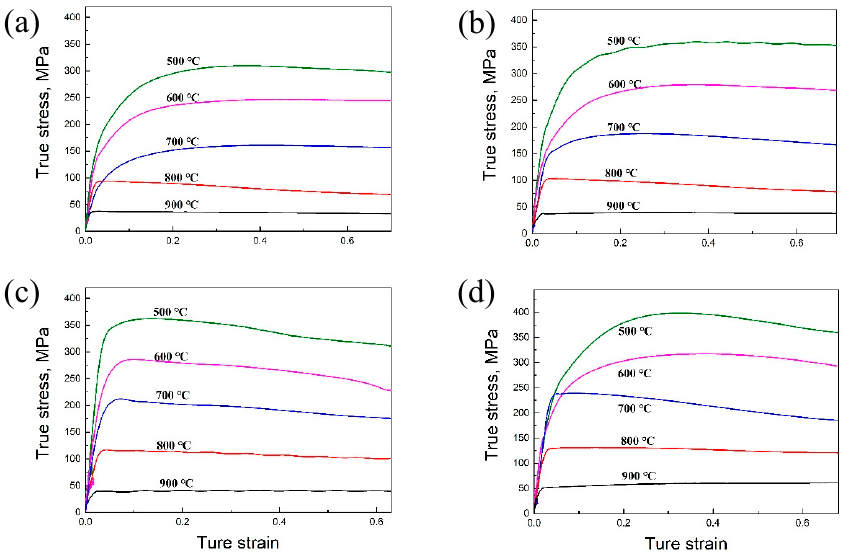
Figure 1. Flow stress–strain curves of the new type of Cu-1.1–Ni-0.7–Co-0.45–Si-0.3Cr alloy at different compression temperatures with different strain rates: ( a ) 0.001 s − 1 , ( b ) 0.01 s − 1 , ( c ) 0. 1 s − 1 , ( d ) 1 s − 1 .